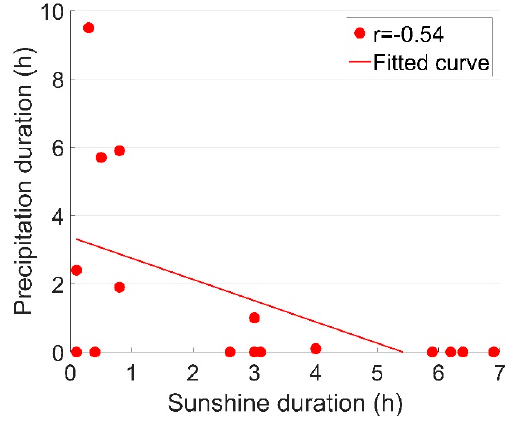
Figure 14. Correlation results between the sunshine and precipitation durations ( D s -D p ).